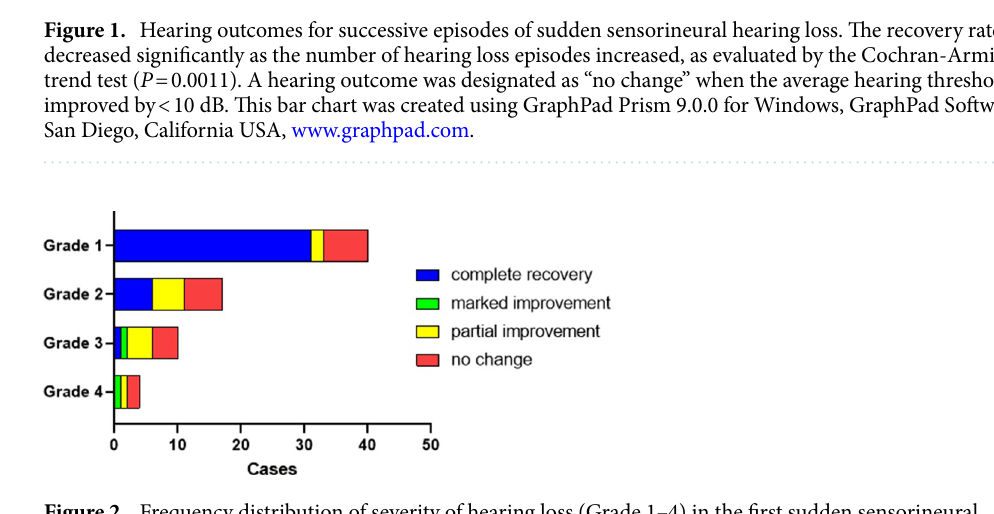
We were able to evaluate the amount of recovery for 71 first SSNHL episodes (Fig. 1). For first SSNHL epi- sodes, 38 (53.5%) showed complete recovery of hearing; 2 (2.8%) showed marked improvement; 12 (16.9%) showed partial improvement; and 19 (26.7%) showed no change. For the 25 second SSNHL episodes, 7 (28.0%) showed complete recovery; 2 (8.0%) showed marked improvement; 5 (20.0%) showed partial improvement; and 11 (44.0%) showed no change. For the 11 third and subsequent SSNHL episodes, 1 (9.1%) showed complete recovery; 6 (54.5%) showed partial improvement; and 4 (36.4%) showed no change. The CATT revealed that the recovery rate decreased with each successive hearing loss episode ( P = 0.0011). The severity of HL for the first SSNHL episodes, stratified by classification of recovery (complete to no change) is shown in Fig. 2. The amount of recovery decreased as HL severity increased (Grade 1 to 4), a trend that was significant ( P < 0.01; CATT). That is, there were progressively fewer instances of complete recovery in those classified as Grade 4 (most severe) compared to Grade 3, Grade 2, and Grade 1 (least severe). The greatest proportion of complete recovery classifications occurred in those with Grade 1 HL, while no complete recoveries occurred in those with Grade 4 HL (Fig. 2). Most audiogram shapes (59%) collected during the first SSNHL episodes had high-frequency descend- ing forms or U-shaped forms (Fig. 3). Audiogram shape was significantly related to recovery rate ( P =0 .048) (Fig. 4). Residual analysis based on the results of Chi-squared test revealed recovery of hearing in patients having U-shaped audiograms was significantly greater than in patients having the other audiogram forms ( P < 0.05) and the amount of recovery for the profound form was significantly less than that of the other audiogram forms ( P < 0.05) (Fig. 4). We also evaluated any possible relationships between VS-tumor size and severity of hearing loss, tumor size in the IAC, and audiogram shape (data not shown). Koos classification of tumor size and severity of hearing loss were unrelated ( r = − 0.116, P =0 .327; Spearman’s rank correlation test). There was also no significant correla- tion between tumor size in the IAC and severity of hearing loss ( r = − 0.14, P = 0.24; Spearman’s rank correlation test). Similarly, there was no significant relationship between Koos classification and audiogram shape ( P = 0.93) or tumor size in the IAC and audiogram shape ( P = 0.81; one-way ANOVA). The presence of a VS tumor in the fundus of the IAC had no significant relationship with the audiogram shape for first SSNHL episodes ( P = 0.70) or amount of recovery shown in the first SSNHL episodes ( P = 0.60; Fisher’s exact test). Finally, tumor growth (yes/no) showed no significant relationship with the recovery of hearing loss ( P = 0.78; Fisher’s exact test). After the first episode of SSNHL, the recurrence-free rate was 69.9% over one year and 57.7% over two years (Fig. 5A). The median (95% confidence interval [CI]) recurrence time for another SSNHL episode was 32 (18–56)